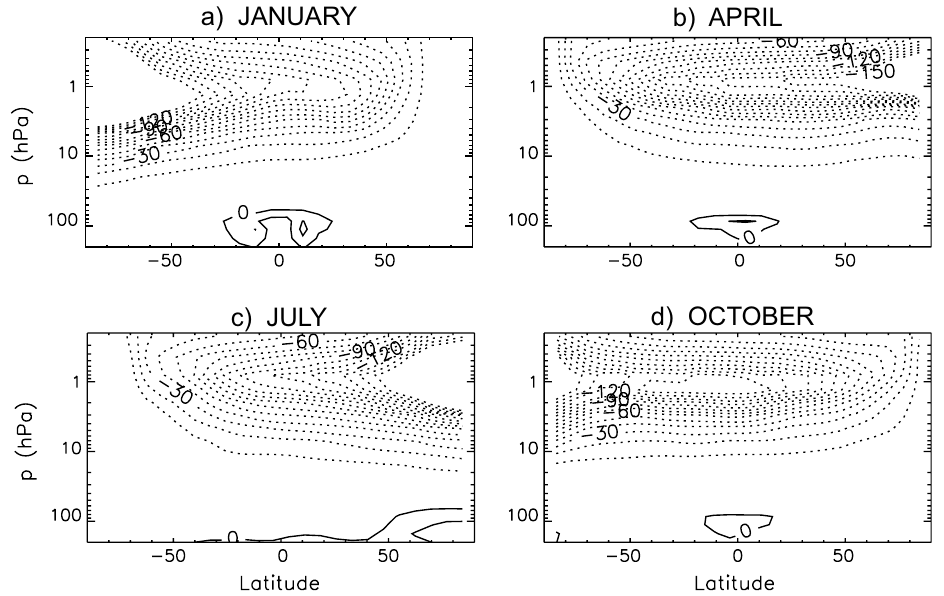
Fig. 4. Altitude–latitude distribution of the CoMeCAT loss tendency with temperature (coefficient c 2 ) in units of (10 − 16 day − 1 K − 1 ) for (a) January, (b) April, (c) July and (d) October. Contours are plotted every 10 units. Solid contours indicate positive values; dashed contours indicate negative